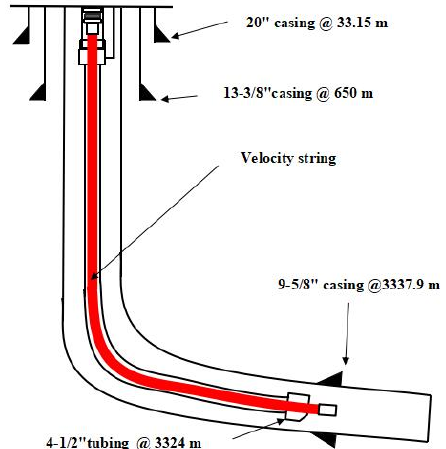
Figure 8. Diagram of casing program and velocity string setting position of well XX-2.